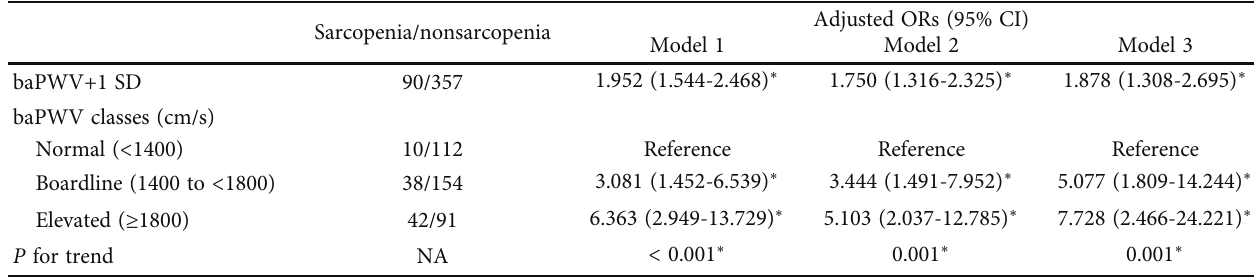
Table 4: Multivariate logistic regression models for elevated baPWV and higher prevalence of